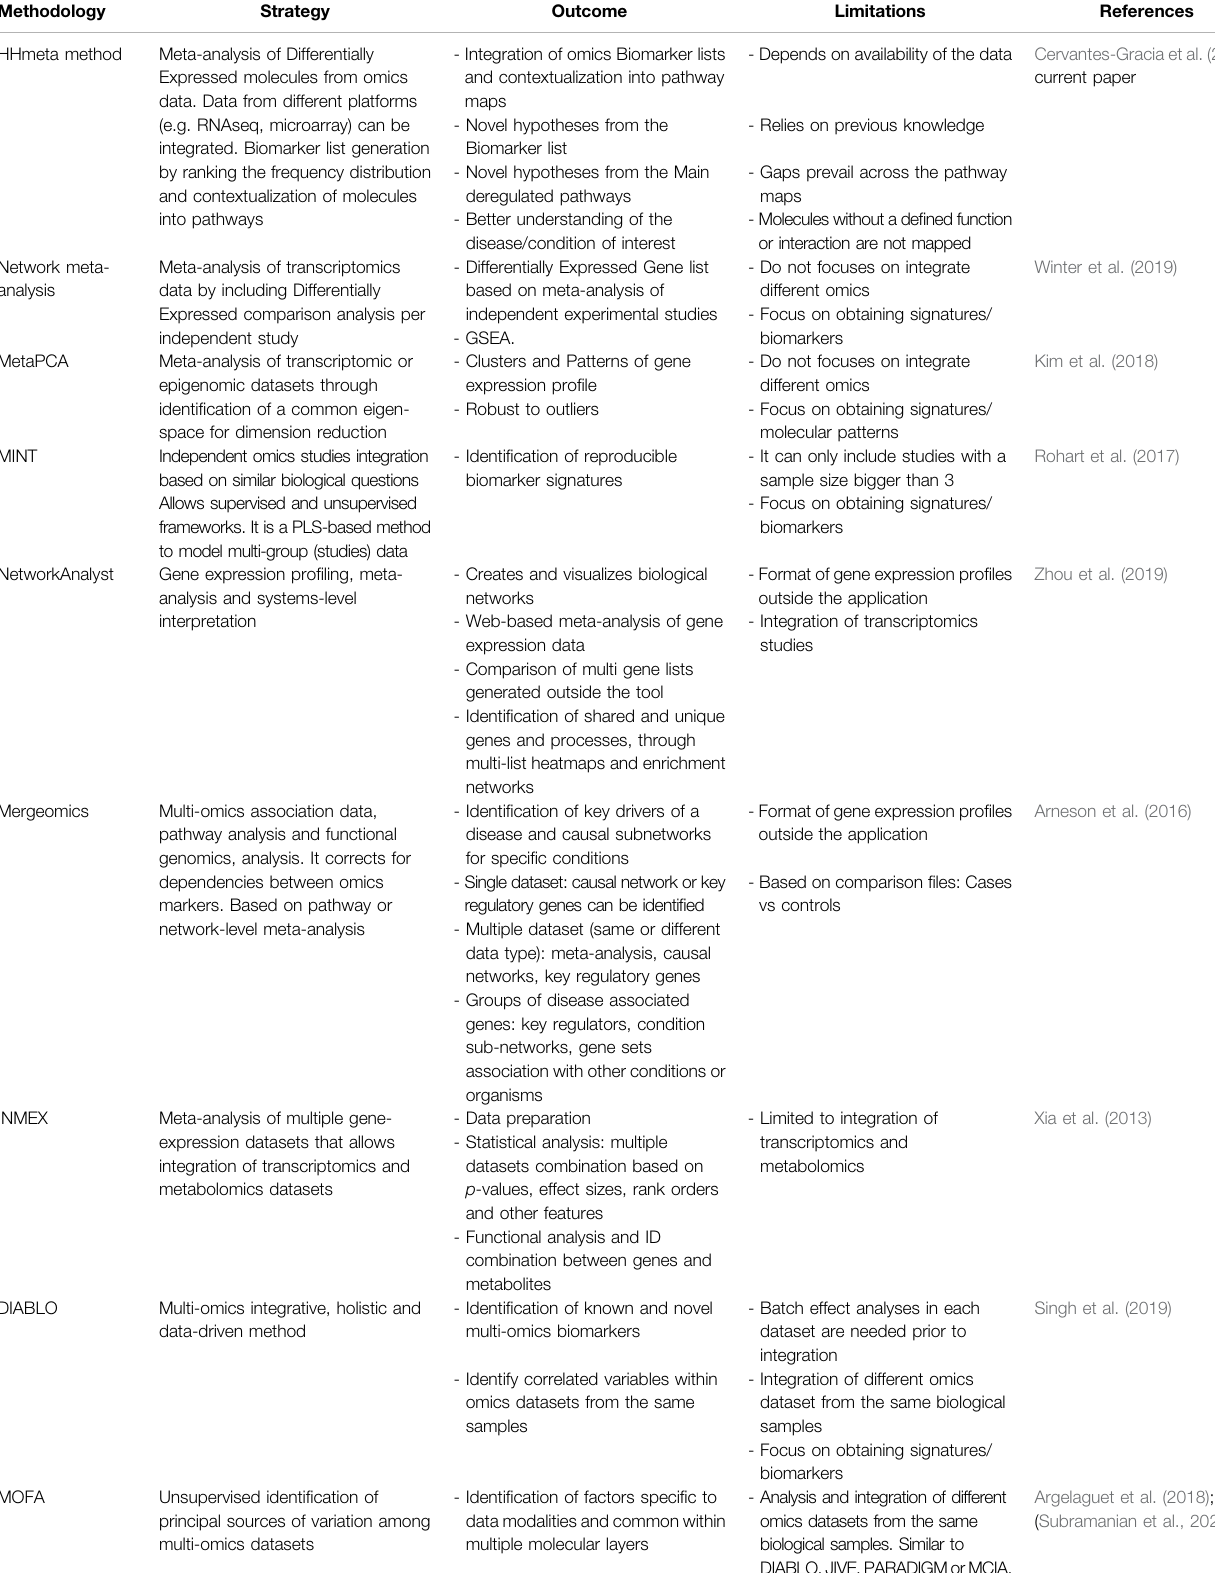
TABLE 1 | Comparison of available integrative systems biology